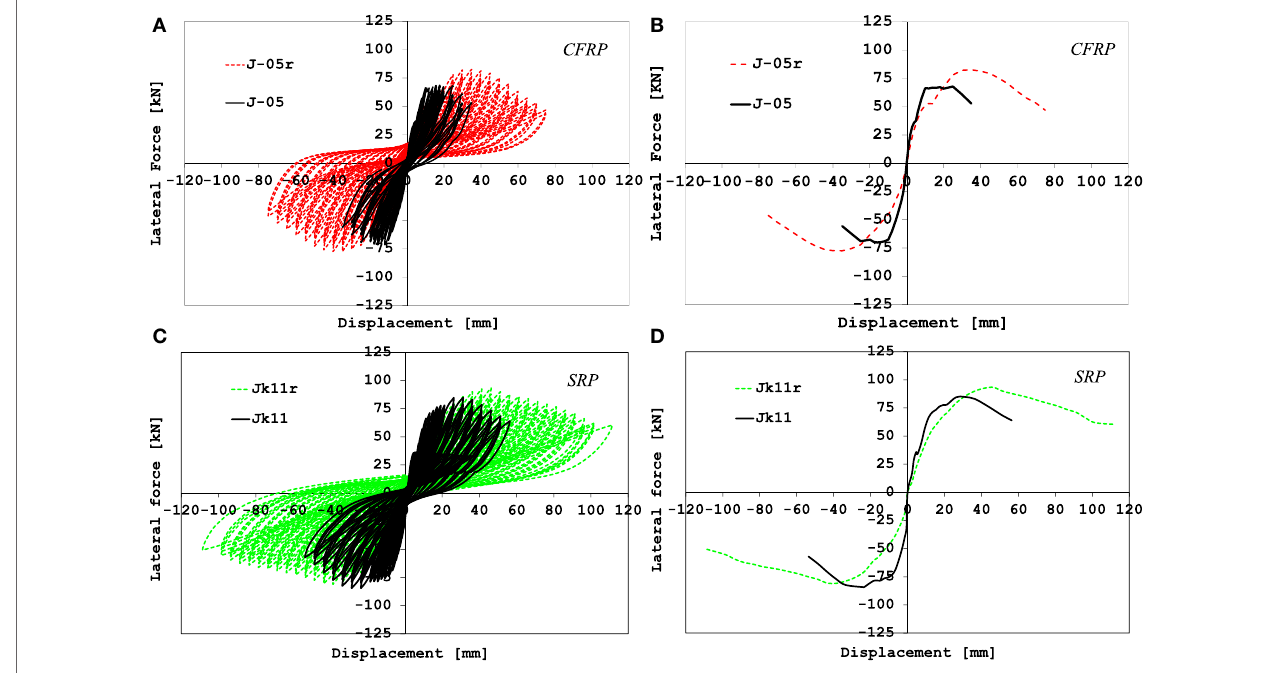
FIGURE 11 | Effectiveness of the CFRP and SRP systems as retrofitting techniques: hysteresis loops (A,C) and envelopes (B,D) .